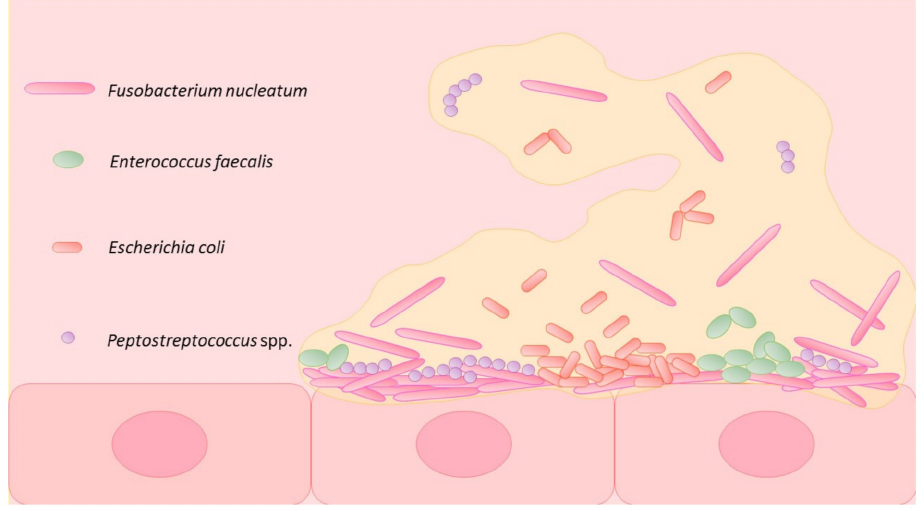
Figure 1. Gut microbiome diversity in colorectal cancer